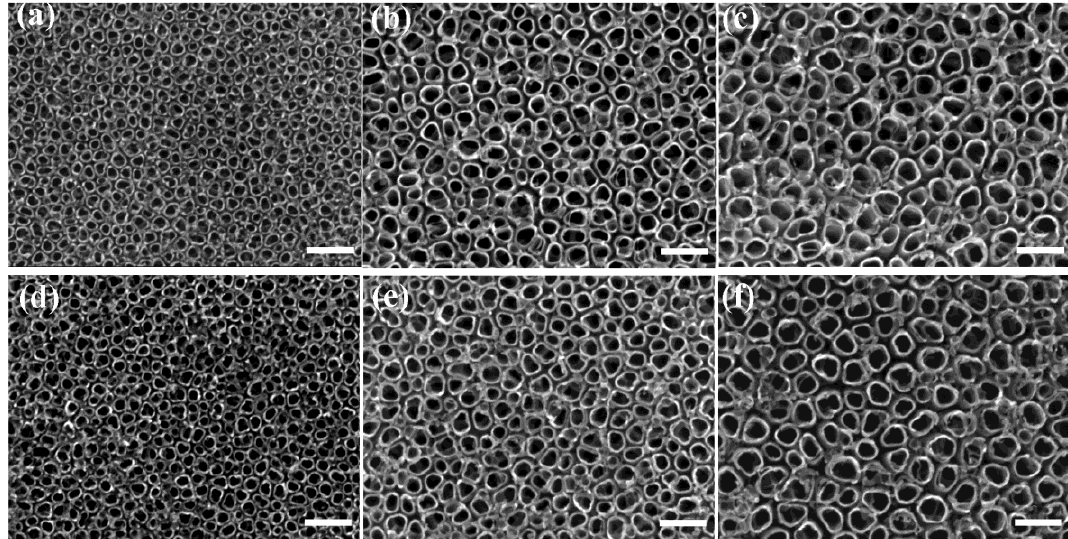
Figure 1. SEM micrographs of samples: ( a ) T-10, ( b ) T-15, ( c ) T-20, ( d ) TV-10, ( e ) TV-15 and ( f ) TV-20 (the scale bare in each image is 200 nm). Table 1. Microstructural parameters of TiO 2 nanotubes with (TV) and without (T) vanadium oxide deposition with standard deviation in brackets.